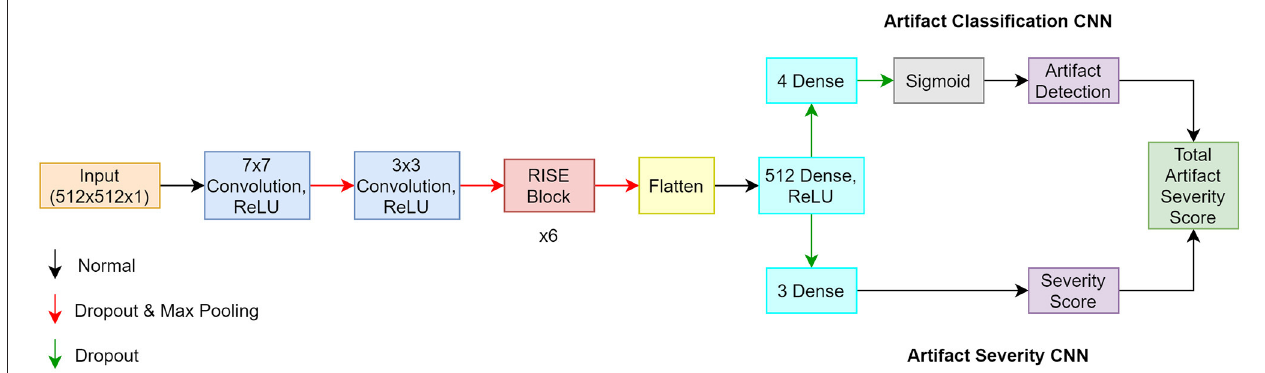
FIGURE 2 | Architecture of proposed algorithm where the classification CNN is the top pathway, and the regression CNN is the bottom pathway.